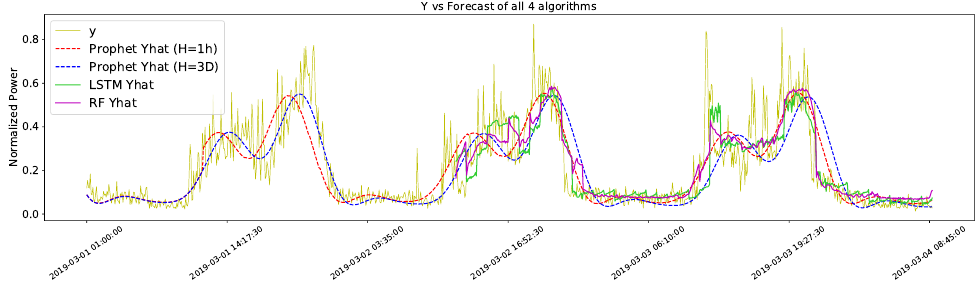
Figure 1. Comparison of the measured data (Y) and the output of the four algorithms.